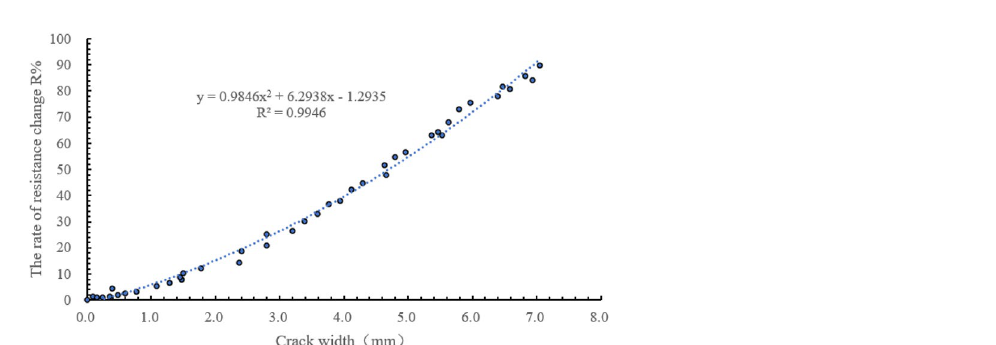
Figure 6. ( a ) Diagram of steel fiber content and compressive strength ( b ) diagram of interaction between B and C, A = 20.